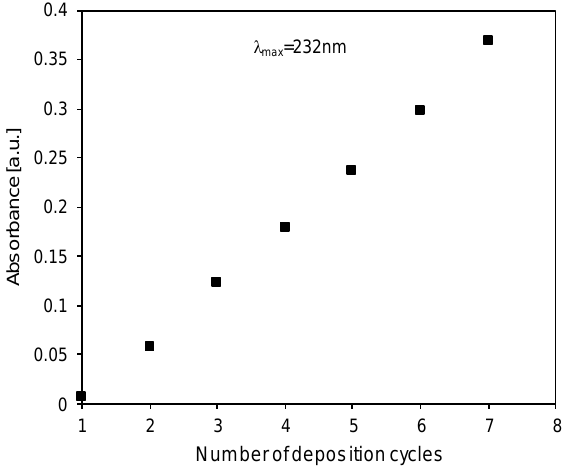
Figure 2. The dependence of the films’ absorbance at λ max = 232 nm on the number of (GO + /GO − ) deposition cycles formed at quartz surfaces.